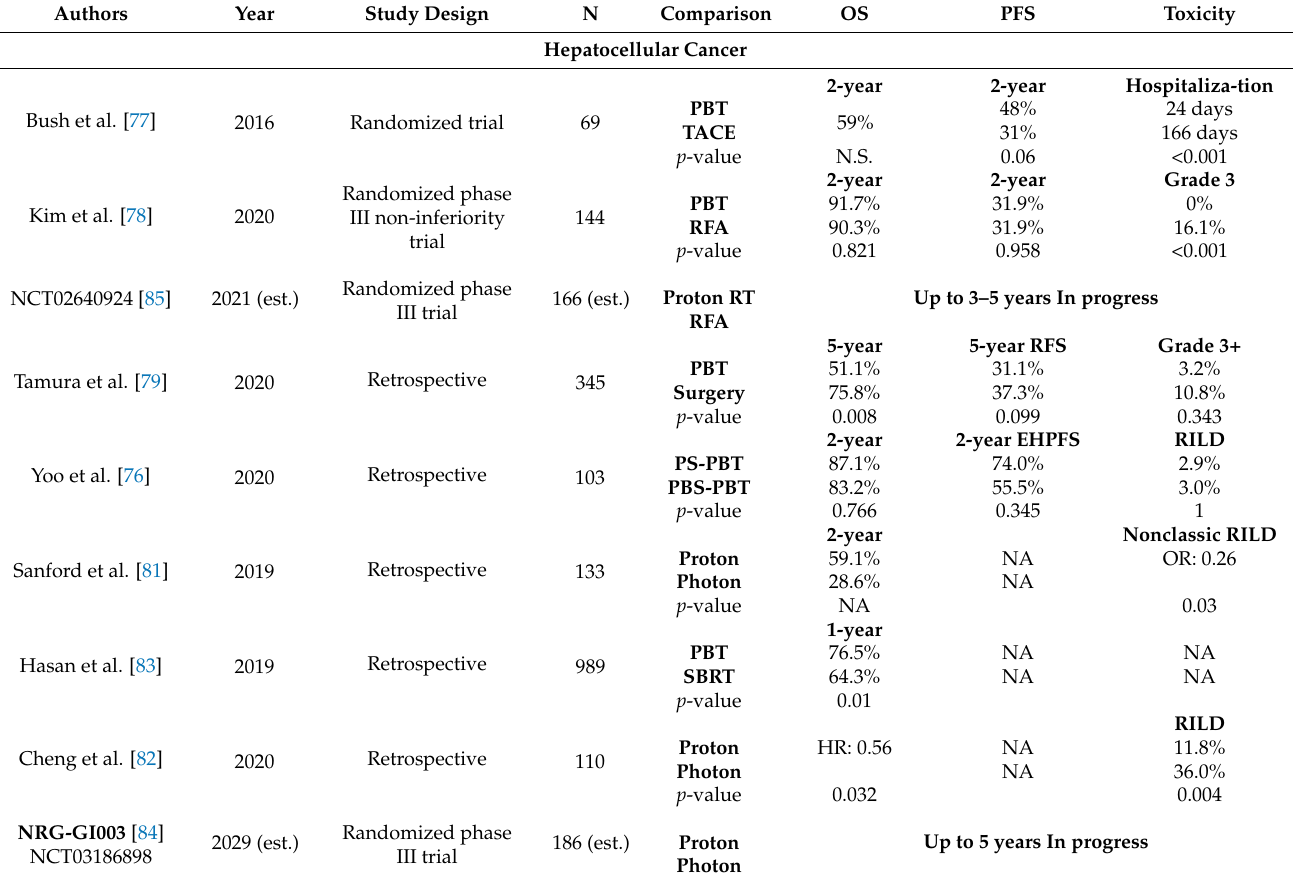
Table 2. Main ongoing and published studies comparing outcomes and toxicities associated with the use of proton radiation therapy versus other local modalities for the treatment of